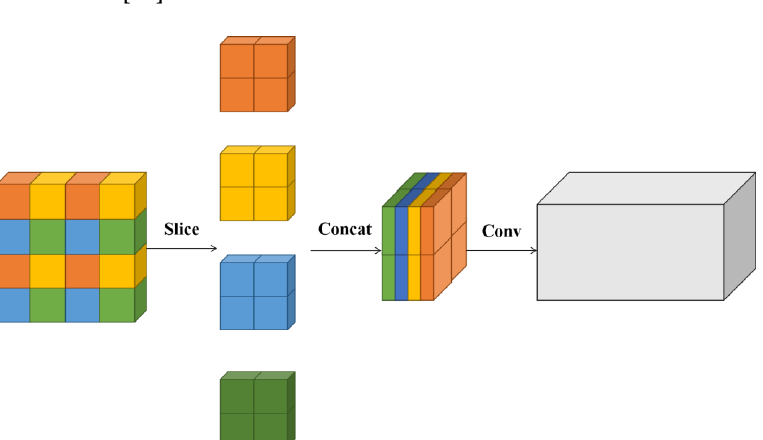
Figure 8. The Focus structure of YOLOv5.